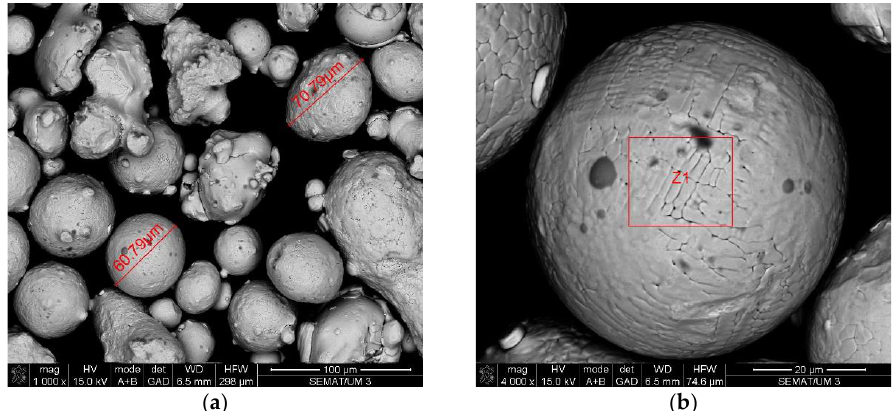
Figure 3. SEM analysis results: Stainless steel 316L raw powder, before any AM process. ( a ) Size and shape of particles in the sample; ( b ) image of the particle analyzed by EDS (results in Figure 4).